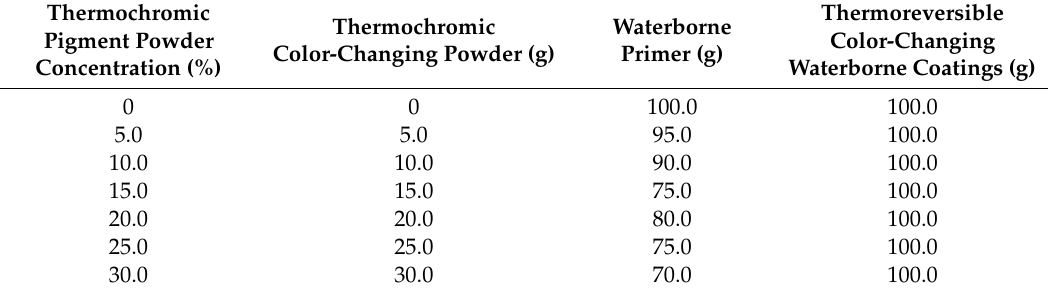
Table 2. Composition of thermochromic color-changing waterborne